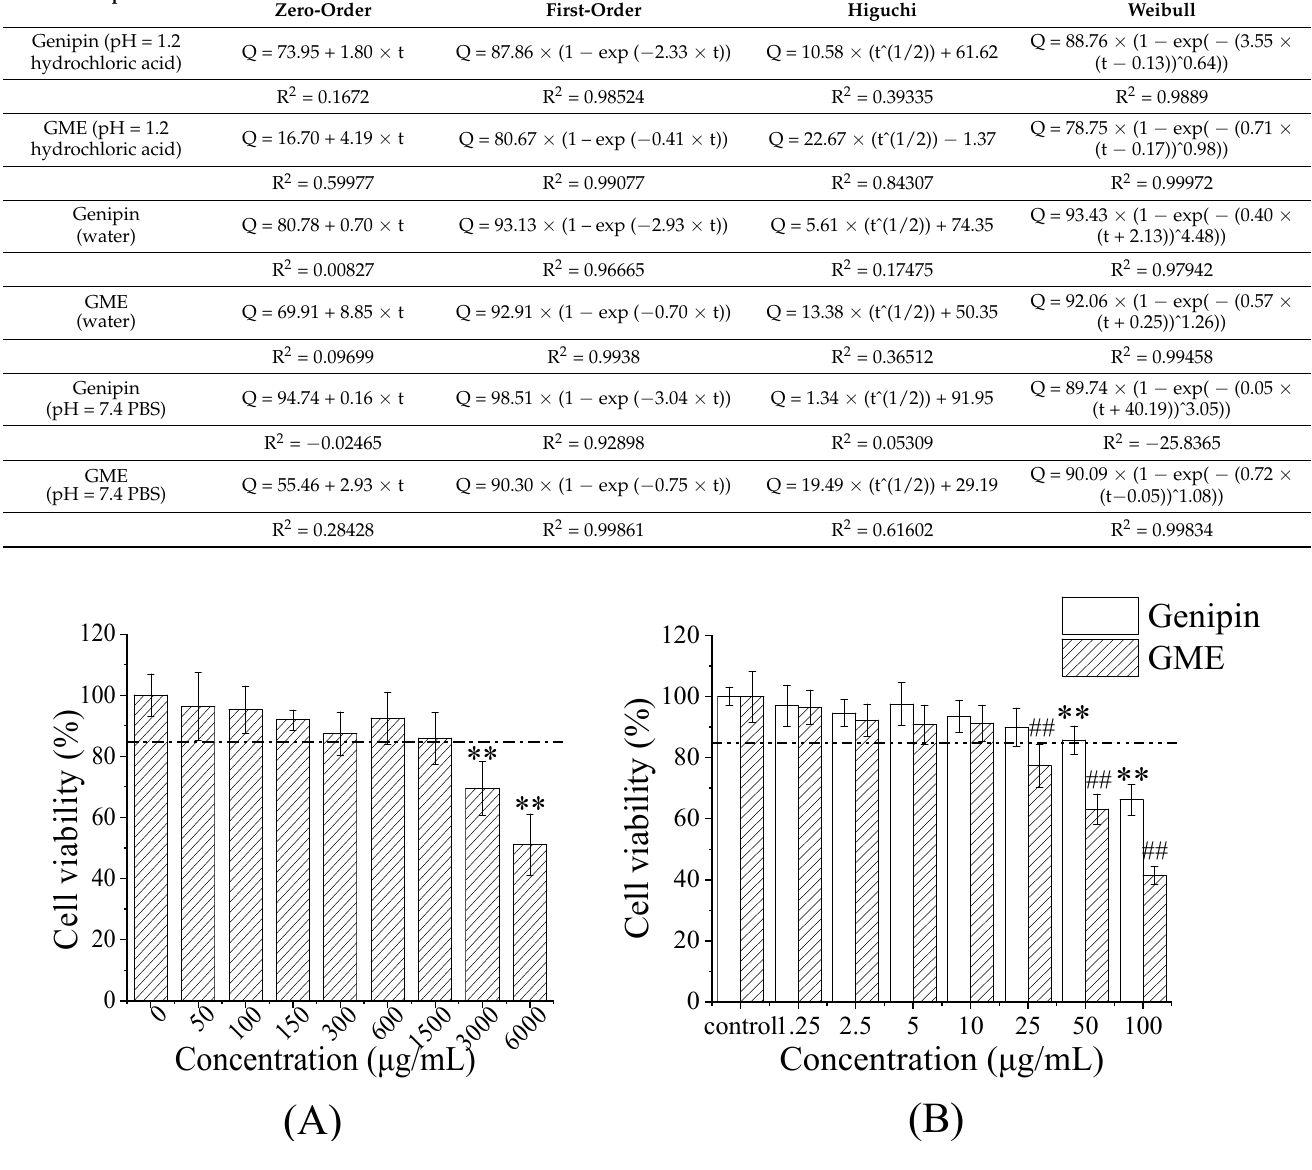
Figure 5. Cytotoxicity of empty microemulsion, free genipin, and GME on Caco-2 cells. Empty microemulsion ( A ); free genipin and GME ( B ). Error bars are SD ( n = 6); ** p ≤ 0.01; ## p ≤ 0.01. Compared with the group treated with the same concentration of free genipin.